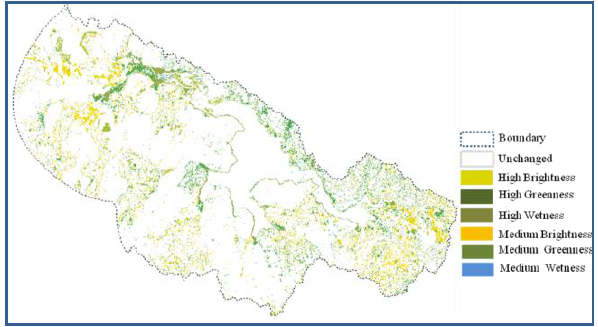
Figure 6. ISODATA classification image In Figure 6 each class indicates intensity of vector change in any direction within the Tasseled Cap Transformation.